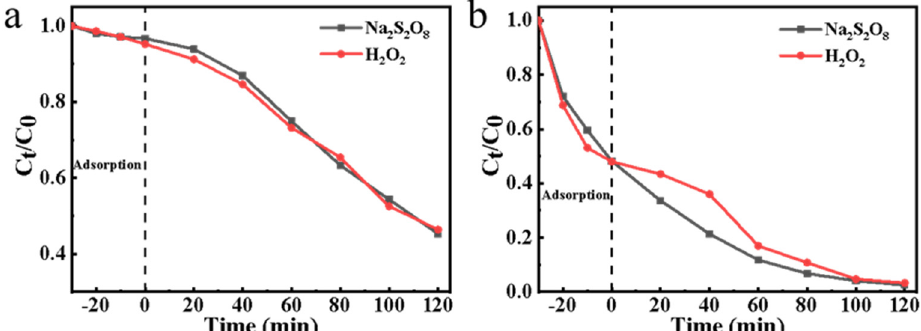
Figure 7. ( a ) Comparison of reduction capacity of atomic hydrogen to H 2 O 2 and Na 2 S 2 O 8 , and degradation of norfloxacin by different free radicals (H 2 O 2 , 3 mM; Na 2 S 2 O 8 , 3 mM; norfloxacin, 10 mg/L; pH, 7.0; applied potential, − 0.8 V vs. Ag/AgCl); ( b ) enlarge the electrode area of ( a ) to 2 × 3 cm 2 for the degradation experiment (H 2 O 2 , 3 mM; Na 2 S 2 O 8 , 3 mM; norfloxacin, 10 mg/L; pH, 7.0; applied potential, − 0.8 V vs. Ag/AgCl).